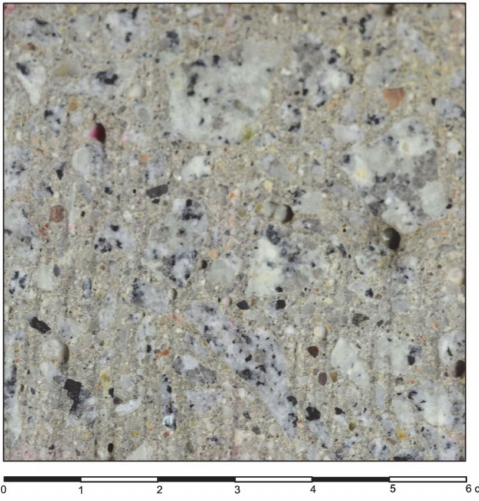
Figure 3. A 60 × 60 mm 2 fragment of the water cut concrete sample